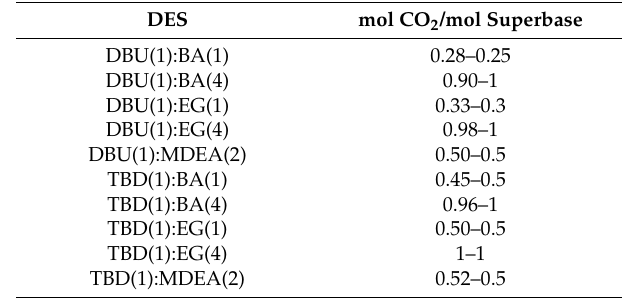
Table 1. CO 2 absorption capacity of the different DBU- and TBD-based DESs as calculated using data coming from the integral of 1 H NMR spectra of DESs after CO2 loading. EG, ethylene glycol; MDEA,